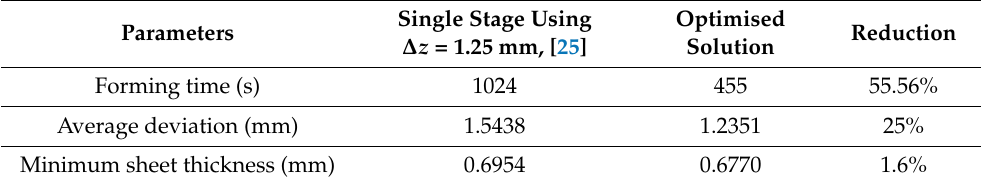
Table 5. Comparison between the forming time, average deviation and minimum sheet thickness.